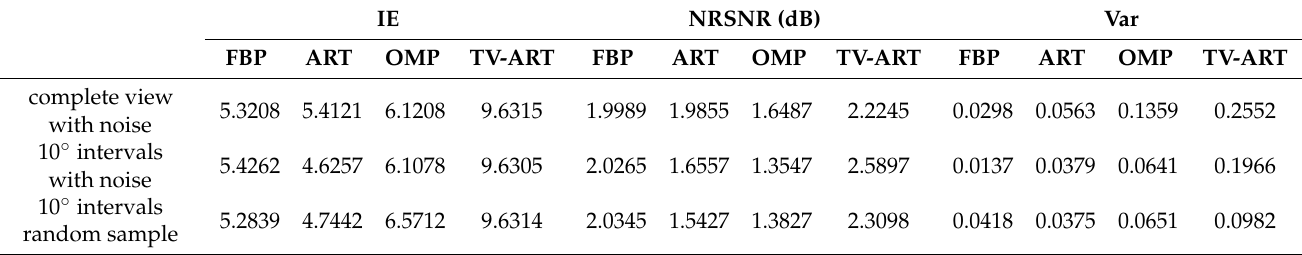
Table 2. Comparison of anti-noise and random sampled results with the three